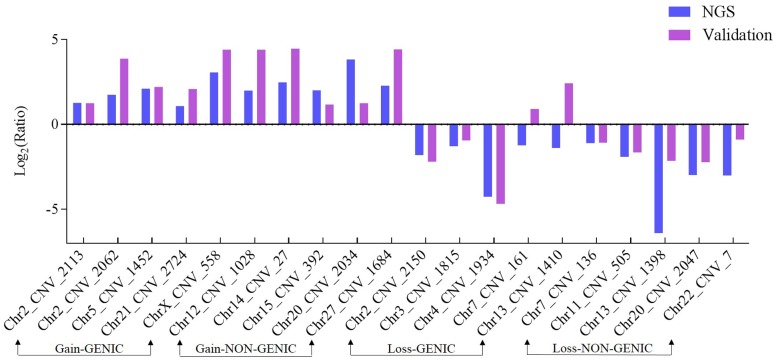
Validation of copy number variations (CNVs) detected from whole-genome resequencing using quantitative PCR.Validation results are shown for four CNVs groups: gain in genic, gain in non-genic, loss in genic, and loss in non-genic. Values on y-axis represented the log2 (2^Sample signal) for resequencing and log2 2-ΔΔCt for qPCR validation, respectively. The two values located in the same side of the "0" line represented the same CNV types, while the values located in two side represented the different CNV types.